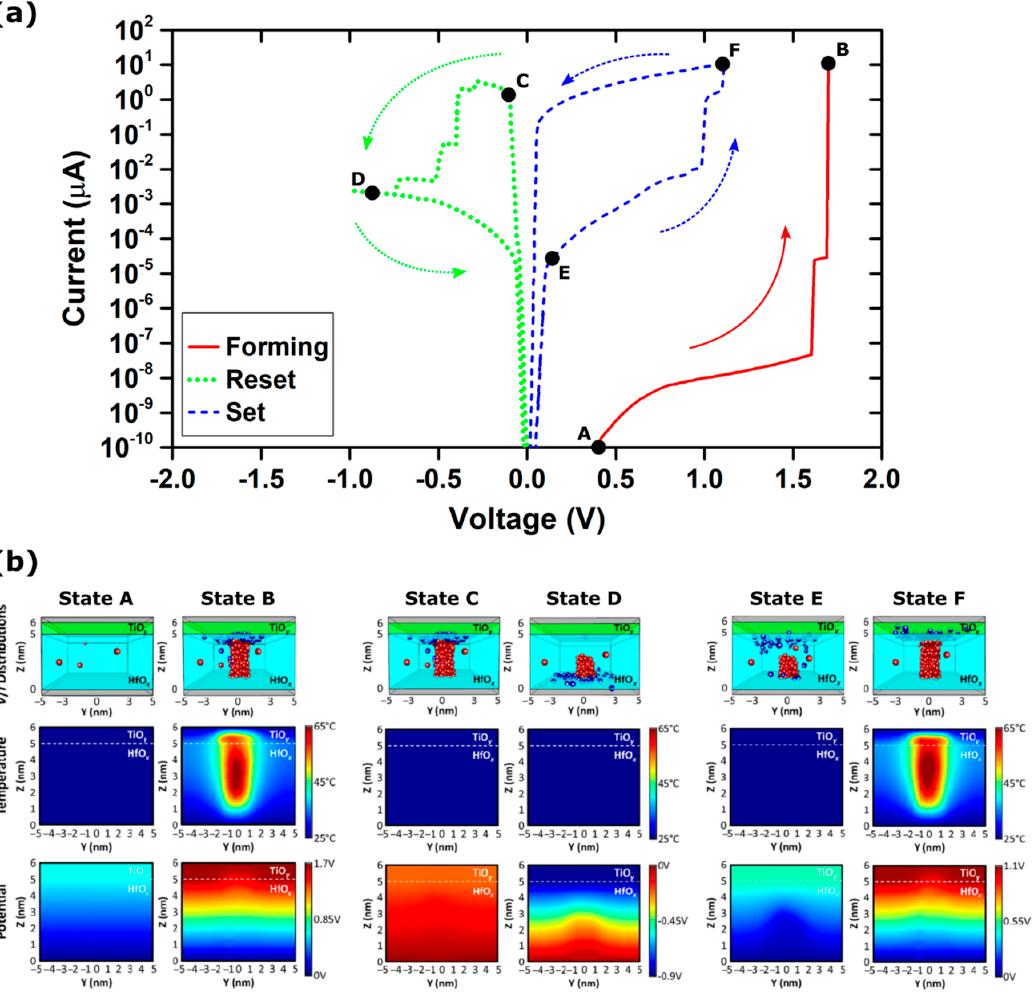
Figure 3. Simulation results of a TiN/5 nm HfO x /TiO y /TiN stack RRAM device: ( a ) Current–Voltage characteristic during forming (solid red), reset (dotted green), and set (dashed blue) operations with a compliance current of 10 µA; ( b ) oxygen vacancy (red spheres) and ion (blue spheres) distribution, temperature profile, and potential profile of the simulated device at different operation stages (labeled A, B, C, D, E, and F in Figure 3a).